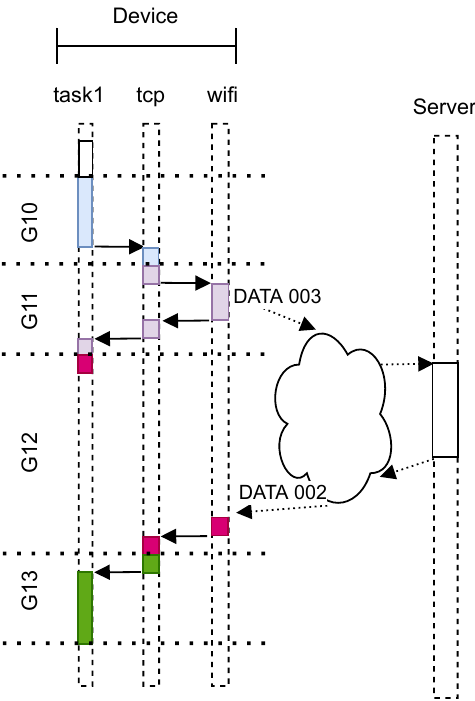
Figure 1. Local task grouping example when benchmarking